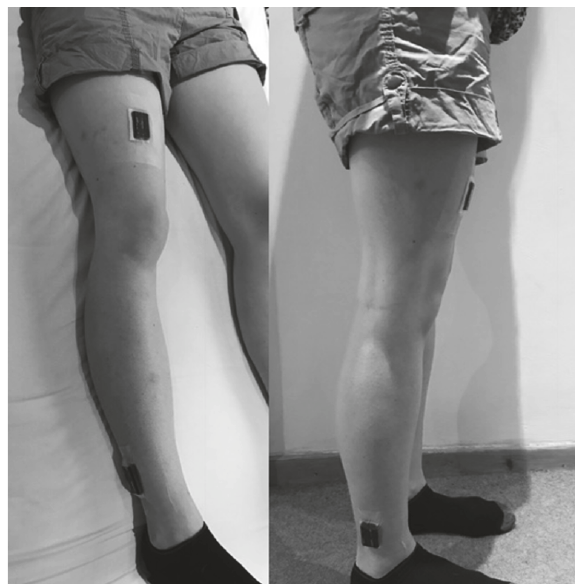
Figure 1: Placement of accelerometers; the accelerometers are orientated with the micro-USB port towards the